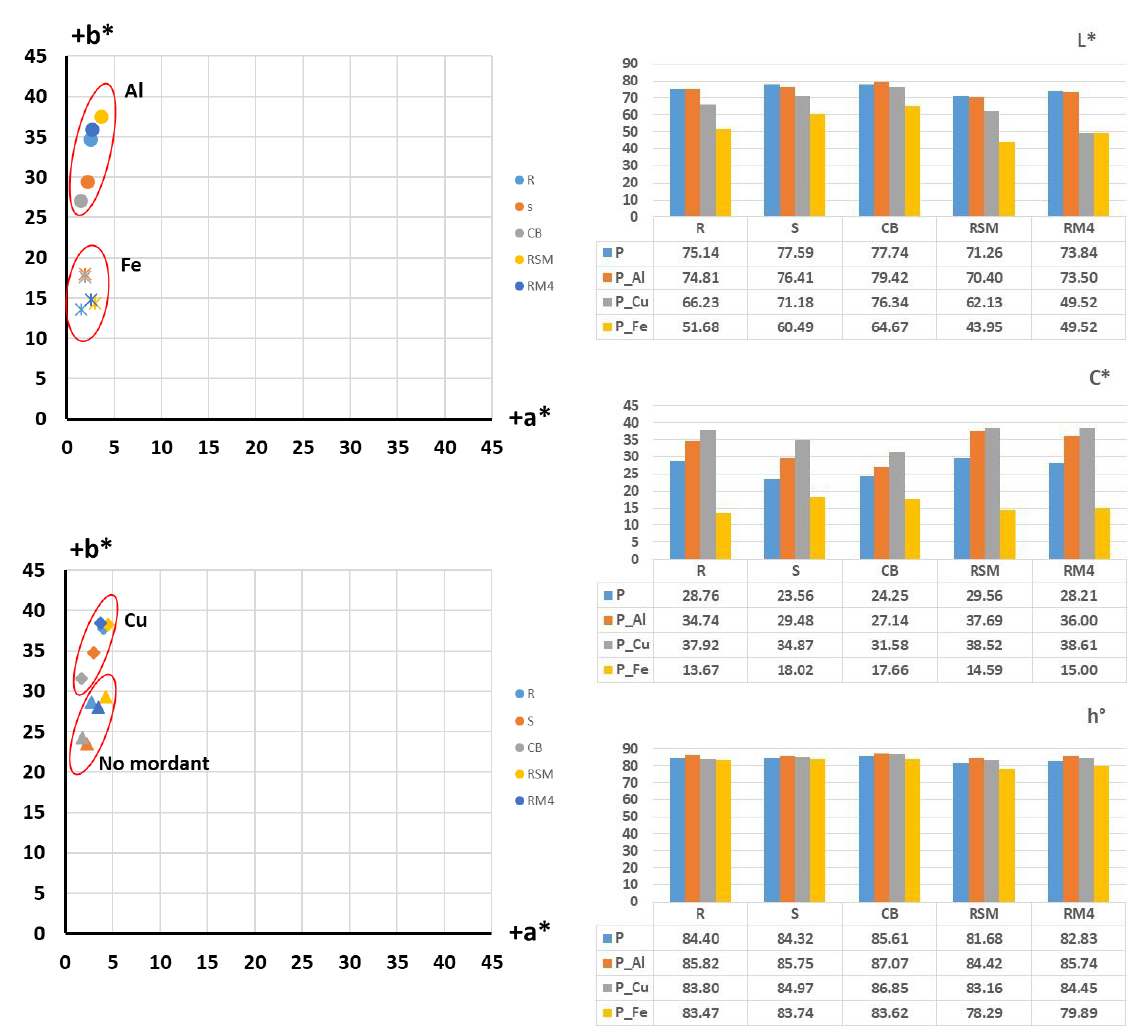
Figure 5. Colour analysis in the a*/b* colour space and objective results of lightness (L*), schroma (C*) and hue (h°) of cotton yarns dyed with pomegranate peel .